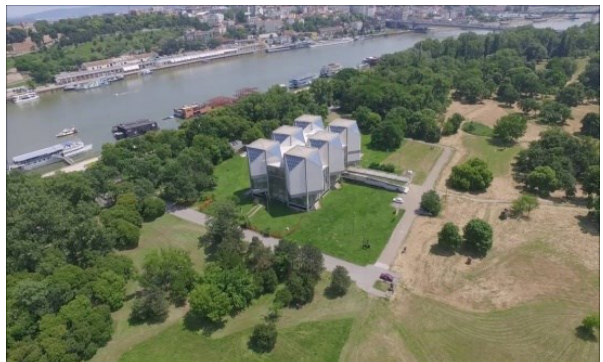
Figure 6. Museum of Modern Art in New Belgrade`s greenery (http://www.slikavest.rs/nove-linije-povodom-otvaranja-